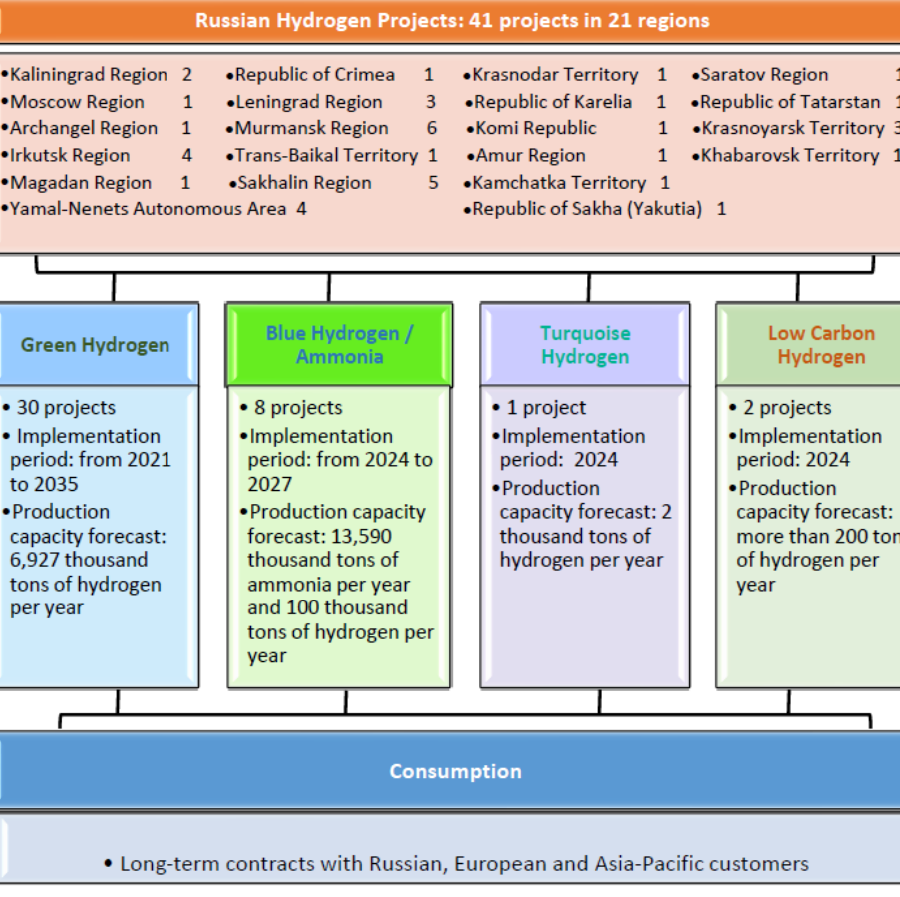
Figure 6. Characteristics of hydrogen projects in Russia, based on Appendix А. Table 2. Present value of hydrogen production in Russia based on electricity from various sources and